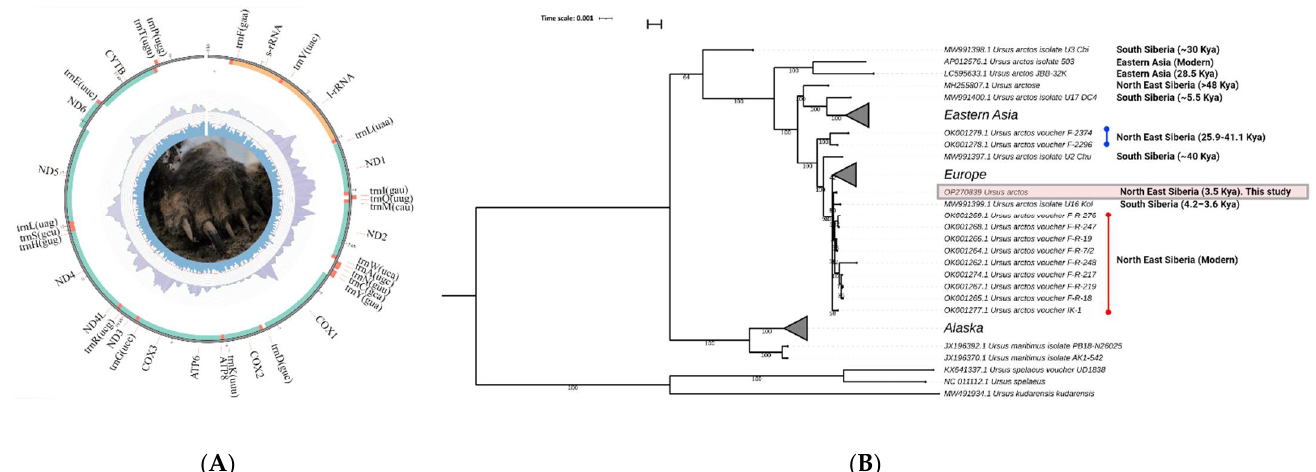
Figure 2. The mitochondrial genome of Holocene brown bear from Bolshoy Lyakhovsky Island (Yakutia, Russia). ( A ) Circular representation of the U. arctos mitochondrial genome. Genes encoded by the heavy (H) strand are shown outside and those encoded by the light (L) strand are shown inside the mitogenome. Different genes are shown as filled boxes in different colours. The inner blue circle represents the GC content. The inner grey circle represents the mitogenome coverage. The brown bear limb (specimen number: MM-F54) is shown in the centre of the Figure. ( B ) Maximum likelihood phylogenetic tree of Ursus species, including the Holocene brown bear from Bolshoy Lyakhovsky Island (marked by a red box), based on their mitochondrial DNA sequences. Bootstrap values are shown in the nodes of the tree.